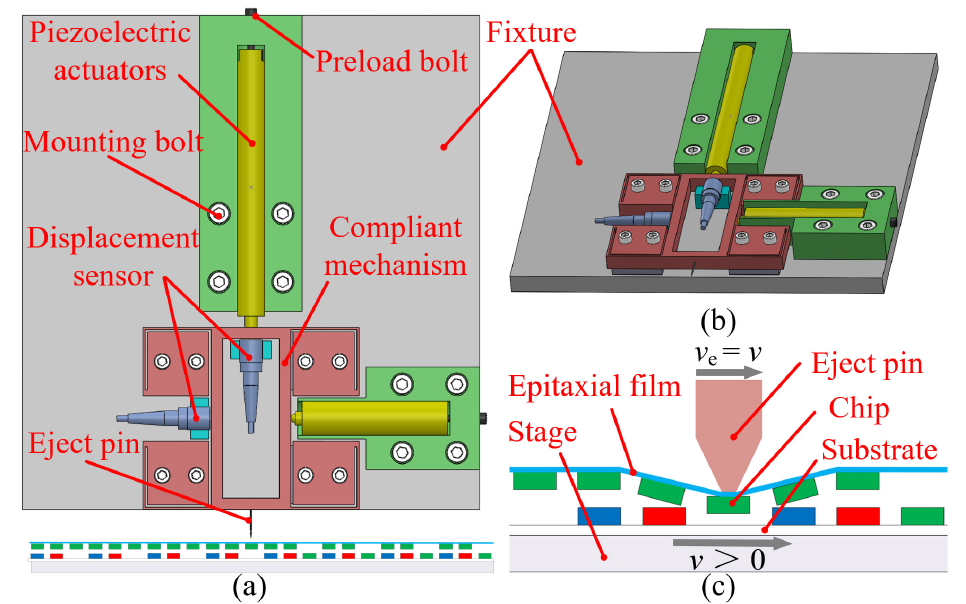
Figure 2. Compliant 2-DOF ejector pin mechanism for the mass transfer of robotic mini-LED chips. ( a ) Schematic diagram of the designed mini-LED transfer device. ( b ) Three-dimensional diagram of the designed device. ( c ) Schematic diagram of continuous chip